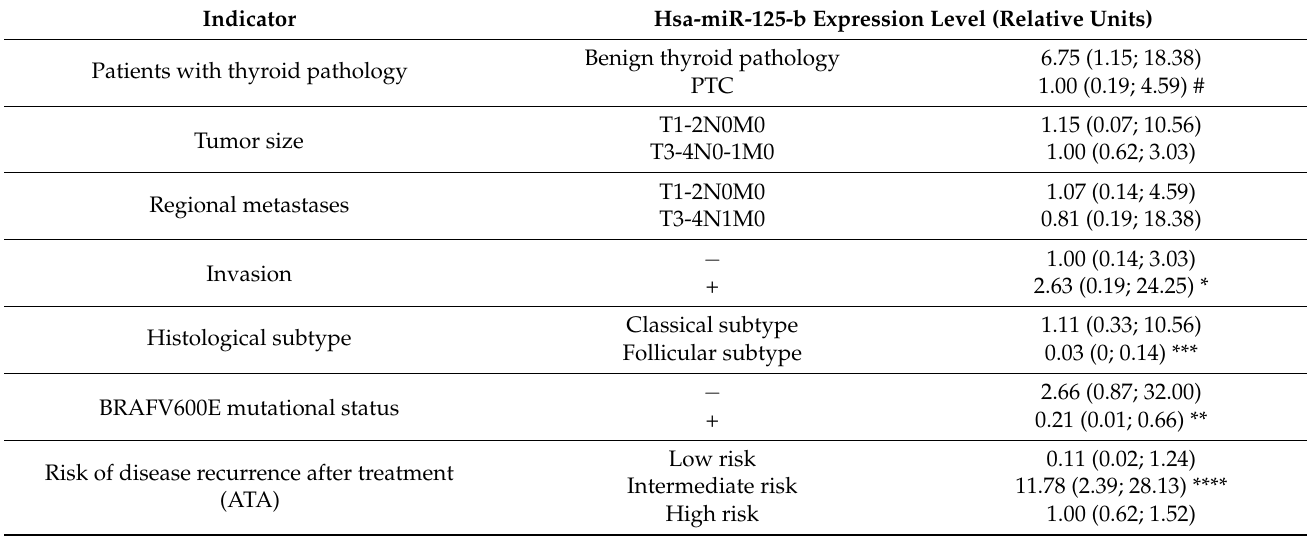
Table 4. The miR-125b expression in tumor tissue in patients with thyroid